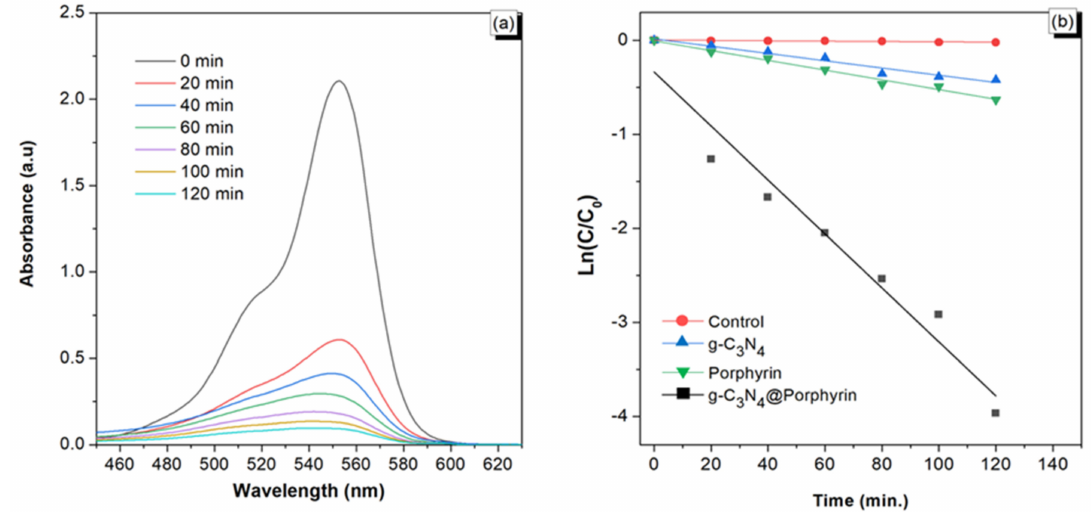
Figure 7. Effect of photocatalytic time on the removal efficiency of RhB using ( a ) the g-C 3 N 4 /porphyrin hybrid material prepared with a TCPP:g-C 3 N 4 ratio of 1:3 (M3) as the pho- tocatalyst and ( b ) the kinetics study of the photocatalysts under irradiation of simulated sunlight for 120